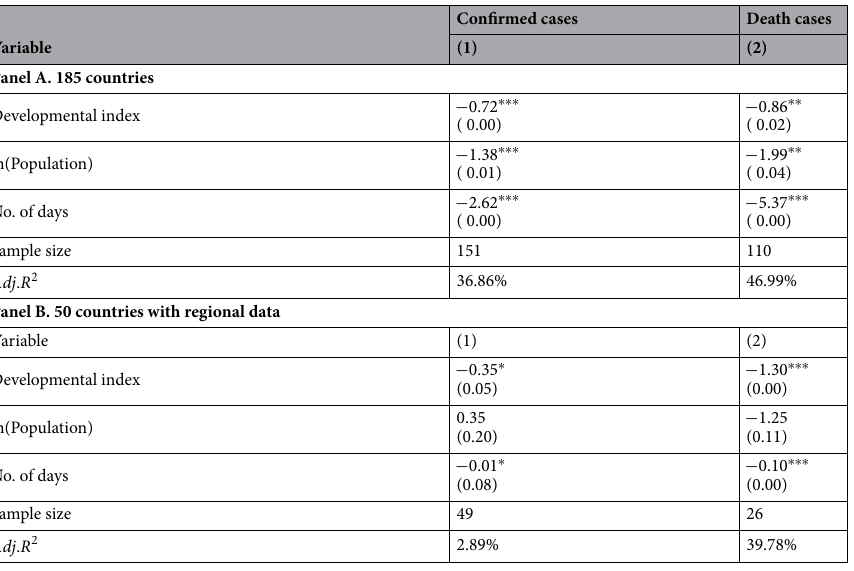
Table 4. Second digit tests. The table presents the results of estimating Eq. (6) using OLS. The dependent variable is the D goodness-of-fit measure for second digits. The unit of observation is a country. Panel A shows the results for the whole dataset with 185 countries for the cumulative number of confirmed cases and death cases; panel B shows the results for 50 countries with regional data. To avoid small coefficients, we divide the development index and ln(Population) by 100 and No. of days by 1000 for all models. Sample sizes vary due to missing values. P -values for a one-tailed t -test are in parentheses. ***, **, and * denote significance at the 1%, 5% and 10% levels,